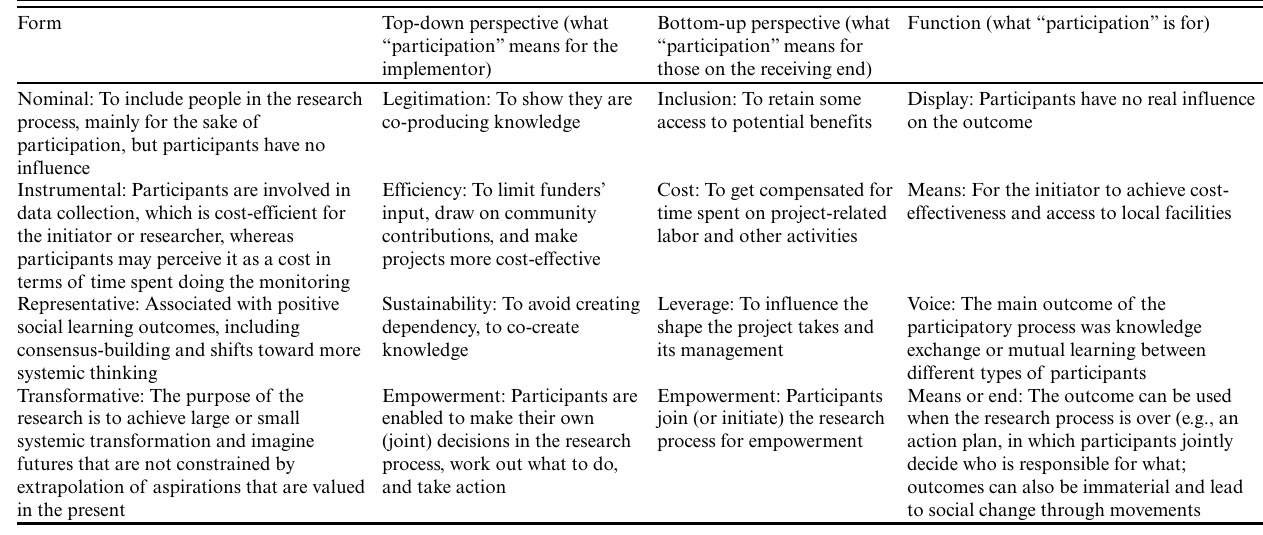
Table 5. White’s (1996) typology in the context of the participatory scenario development process, based on the reviewed articles. Form Top-down perspective (what Bottom-up perspective (what Function (what “participation” is “participation” means for the “participation” means for implementor) those on the receiving end)